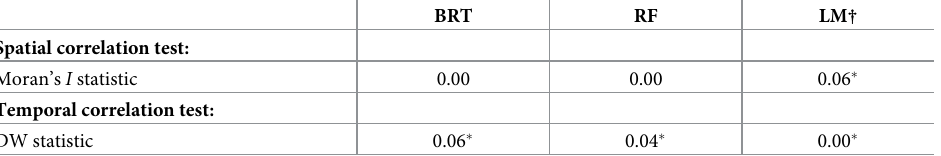
Table 4. Spatial and temporal correlation test statistics and statistical significance of the spatial correlation test applied to the cross-validation residuals for the two Machine Learning (BRT, RF) and the Linear Model (LM) methods under